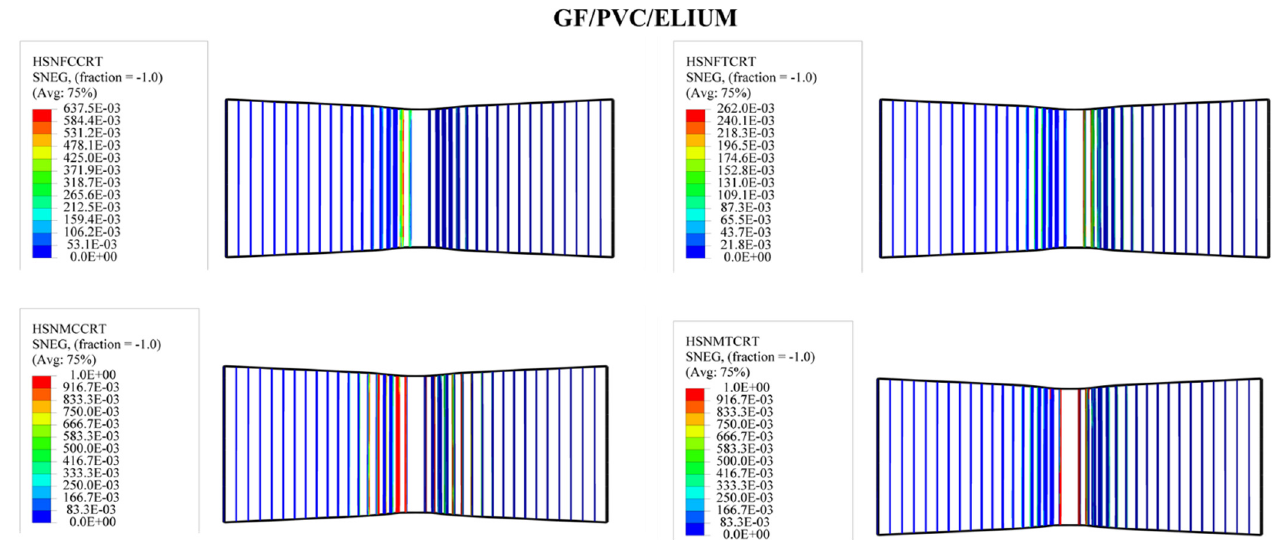
Figure 11. Numerical Hashin’s damage initiation of the upper skin of GF/PVC/Elium sandwich composites.